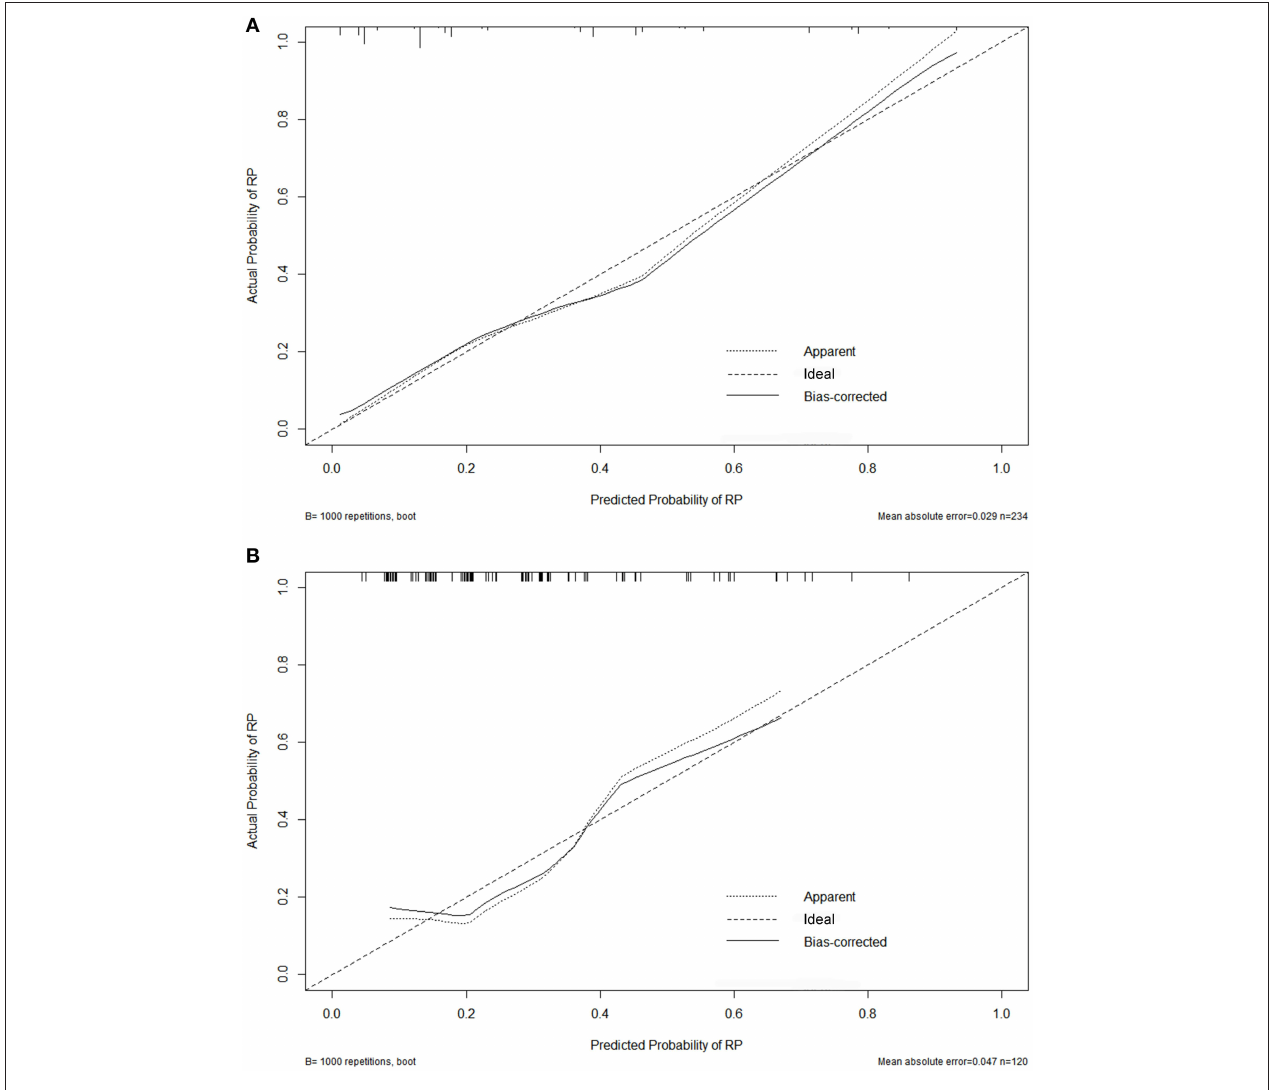
FIGURE 2 | Calibration curves for the nomogram on 10-fold cross-validation (A) and the external validation set (B)